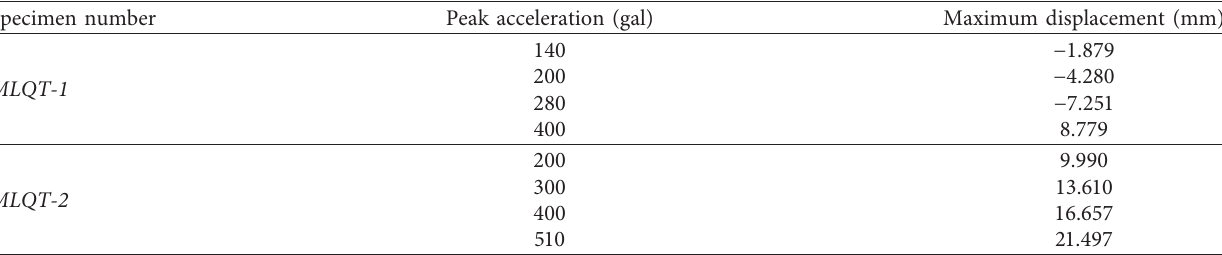
Figure 8: MLQT-4: (a) LRB limit of displacement state; (b) LRB broken state. Table 3: MLQT-1\MLQT-2